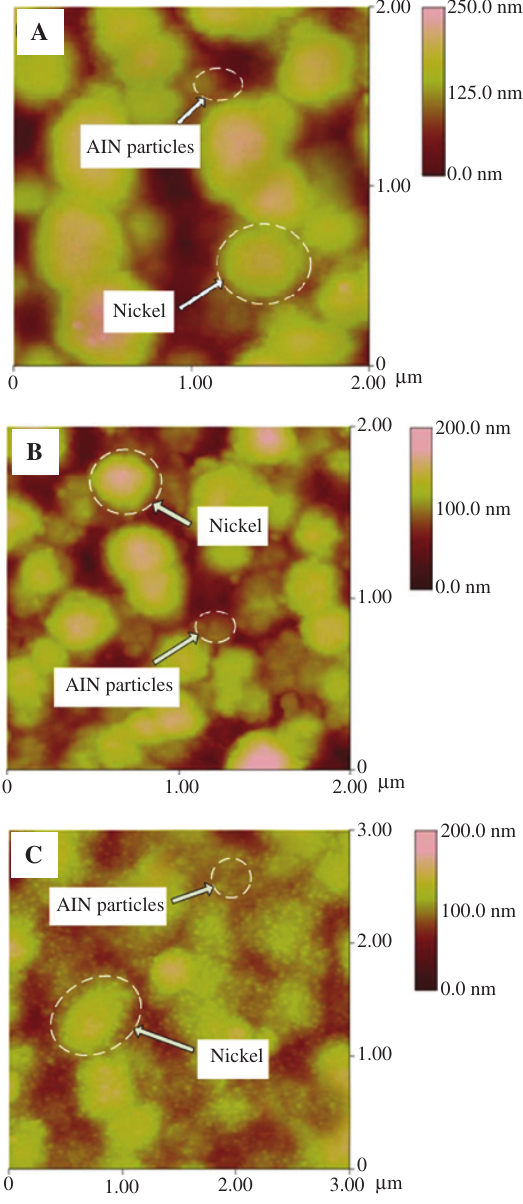
Figure 3 SPM images of Ni-AlN thin films deposited by (A) DC, (B) PC, and (C) UAPC